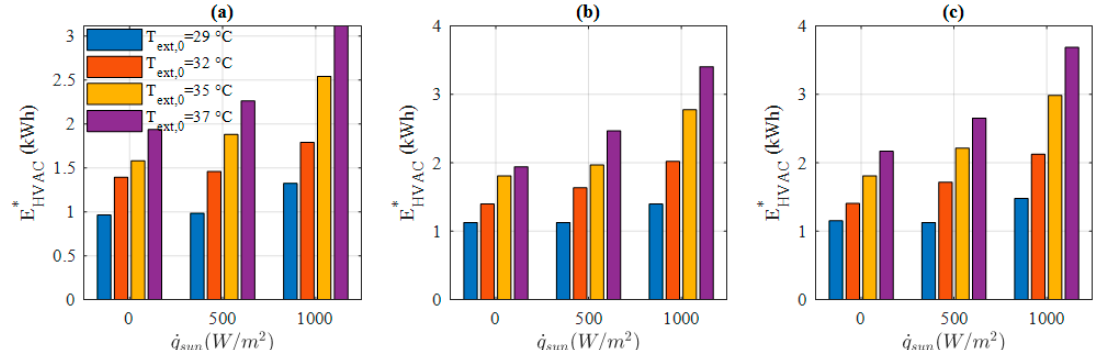
Figure 12. HVAC system consumption E ∗ for four T ext ( t ) and three RH ext ( t ) characterized by: HVAC ( a ) RH ext ,0 = 35%, ( b ) RH ext ,0 = 55%, and ( c ) RH ext ,0 = 75%. Energies 2020 , 13 , x FOR PEER REVIEW 16 of 22 Figure 12. HVAC system consumption 𝐸 (cid:3009)(cid:3023)(cid:3002)(cid:3004)∗ , for four 𝑇 (cid:3032)(cid:3051)(cid:3047) (𝑡) and three 𝑅𝐻 (cid:3032)(cid:3051)(cid:3047) (𝑡) characterized by: ( a ) 𝑅𝐻 (cid:3032)(cid:3051)(cid:3047),(cid:2868) = 35% , ( b ) 𝑅𝐻 (cid:3032)(cid:3051)(cid:3047),(cid:2868) = 55% , and ( c ) 𝑅𝐻 (cid:3032)(cid:3051)(cid:3047),(cid:2868) = 75% .